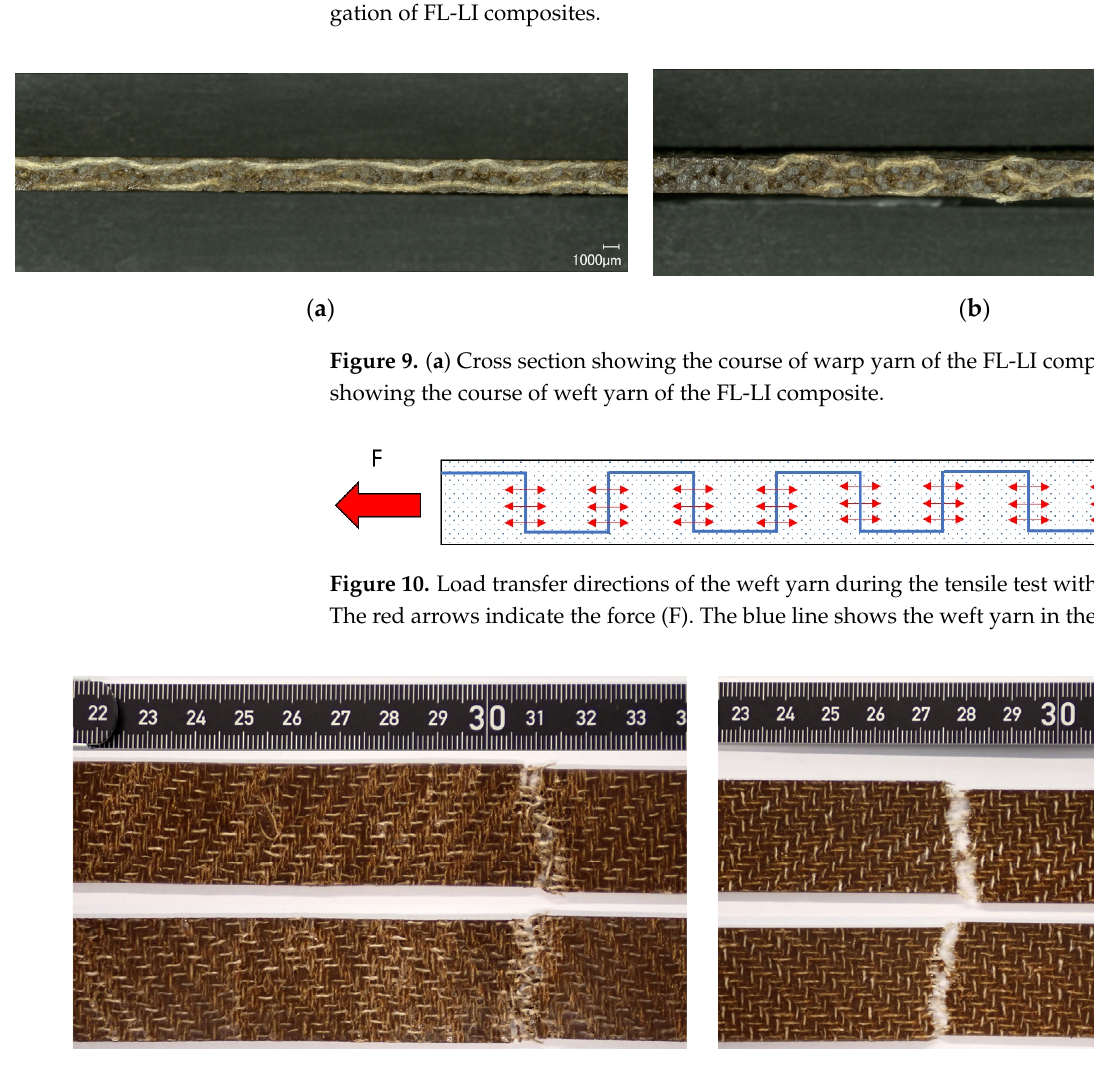
( b ) Figure 12. Blue coloured detailed view on the structure of the fracture zones of selected tensile test specimens:( a ) tensile test in weft direction with plastic deformation along the diagonal twill weave lines; ( b ) tensile test in warp direction without plastic deformation. 3.4.2. Flexural Properties The bending properties of the FL-LI composites were determined in a 4-point bend- ing test according to DIN EN ISO 14125 and are shown in Figure 13a to c. The flexural modulus of elasticity of FL-LI 90° is only slightly lower at 3.52 GPa compared to that of FL-LI 0° at 4.43 GPa. Due to higher yarn density in warp direction (6 yarns per cm) com- pared to that in the weft direction (5 yarns per cm) of the FL-LI fabric, a higher flexural modulus in the warp direction (90°) was expected than in the weft direction (0°). How- ever, the 4-point bending tests proved a higher flexural modulus in the weft direction. The higher flexural modulus in the weft direction (0°) is due to the fact that the weft yarns are located further outside the central neutral bending axis, in the FL-LI composite, than the warp yarns (90°). Below the neutral bending line, the yarns are subjected to tensile stress, and above it, to compressive stress. Thus, the weft yarns, which are further away from the neutral bending line are significantly more stressed during the 4-point bending test. The higher flexural modulus in the weft direction is therefore mainly generated by the weft yarns below the neutral bending line. The same effects as for the flexural modulus are evident in the flexural strength tests. The FL-LI composite has a higher flexural strength in the weft direction (69.05 MPa) than that in the warp direction (39.63 MPa). The weft yarns, which are located more off-centre than the warp yarns in the composite, generate a higher section modulus than the warp